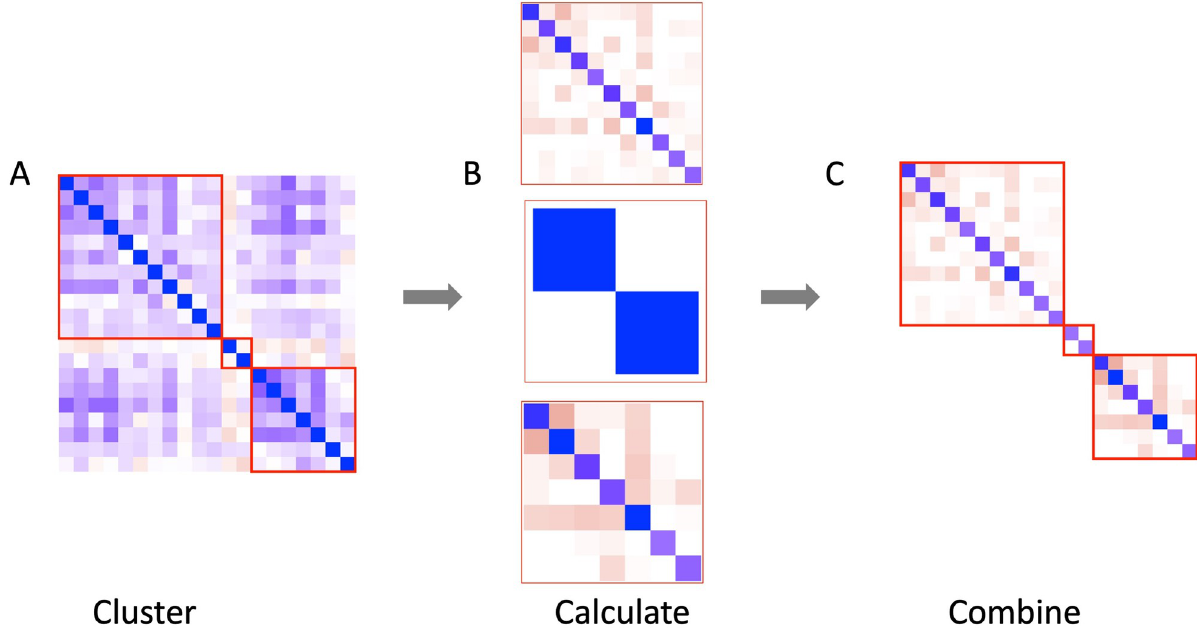
Fig 4. Illustration of block diagonalization and clustering in calculating weighted adjacency matrix. (A) The network is broken into clusters. (B) Weighted adjacency matrix estimation is performed on each cluster separately. (C) Cluster specific matrices are recombined into a single matrix.